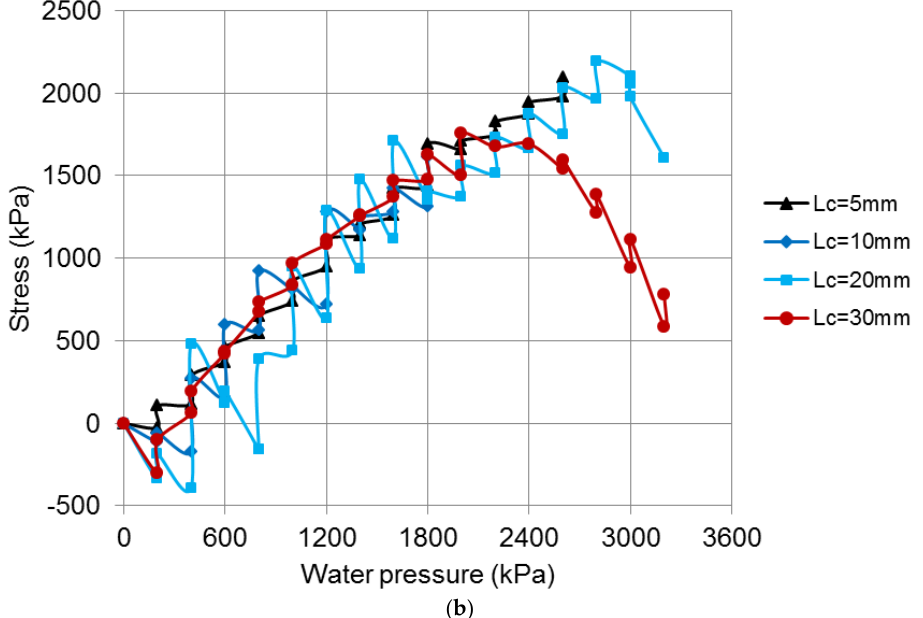
Figure 3. Calculated average vertical stresses of the asphalt specimens in the crack plane versus water pressure for the specimens with different ring crack depths under vertical displacement restraint conditions at ( a ) 5 °C and ( b ) 20 °C, respectively. Positive stress means compressive stress.